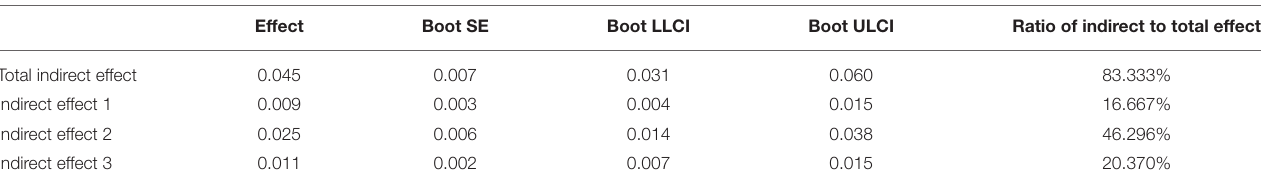
TABLE 4 | Indirect effect of school connectedness and cyber